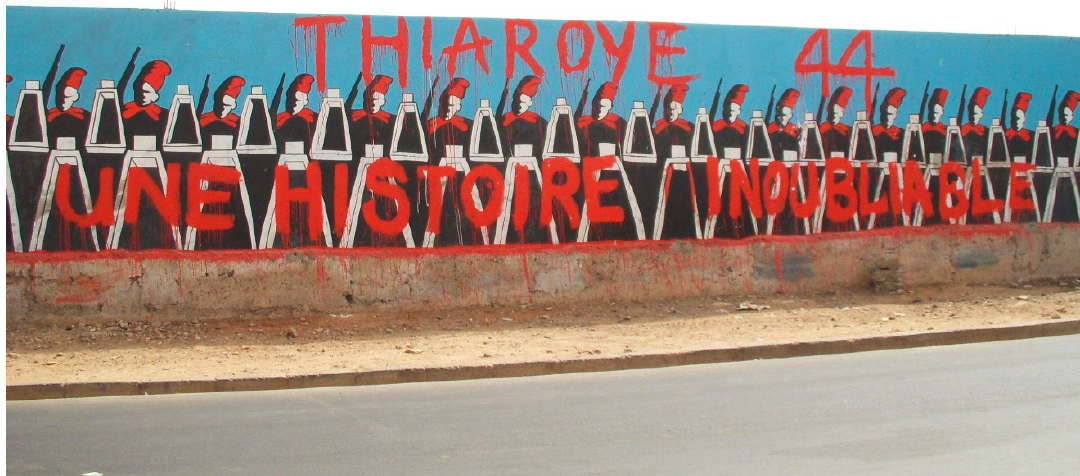
Figure 5. “Thiaroye 44: Une Histoire Inoubliable.” Street Mural in Dakar. Wikimedia Commons (photo by Erica Kowal).